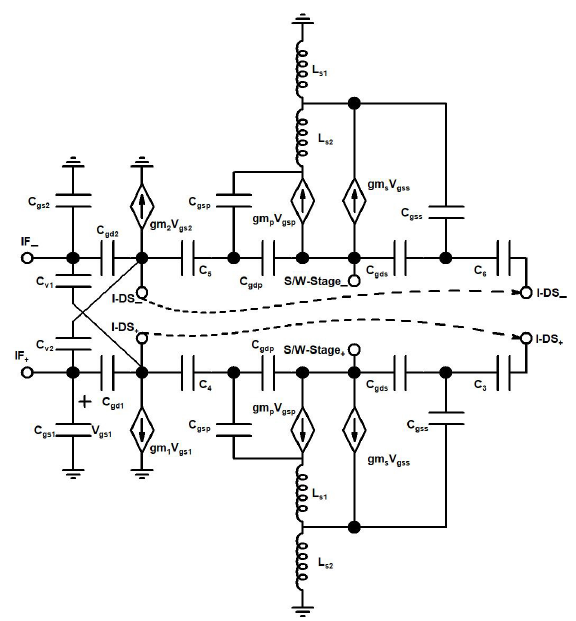
Figure 8. Small signal model of the transconductance